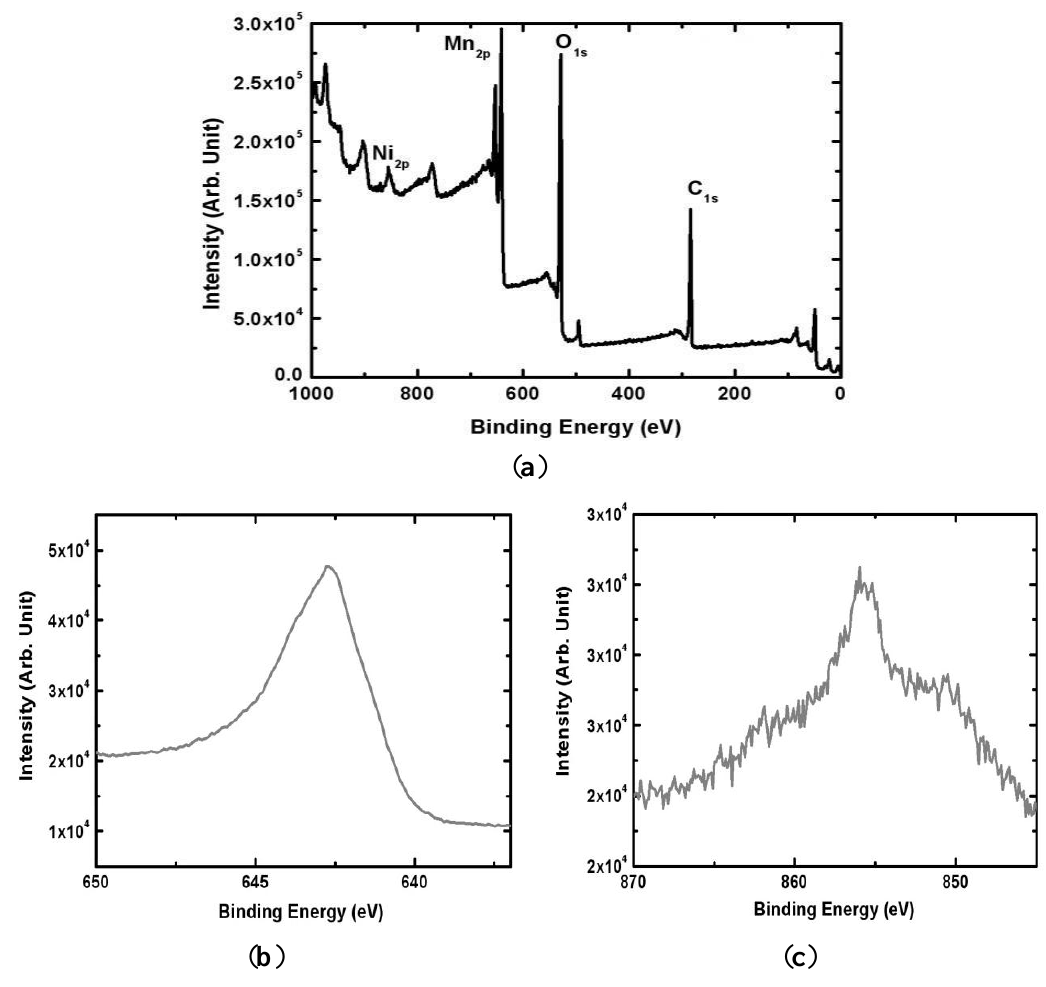
Figure 4. XPS spectra of the electrodeposited Mn-Ni oxide films. ( a ) survey